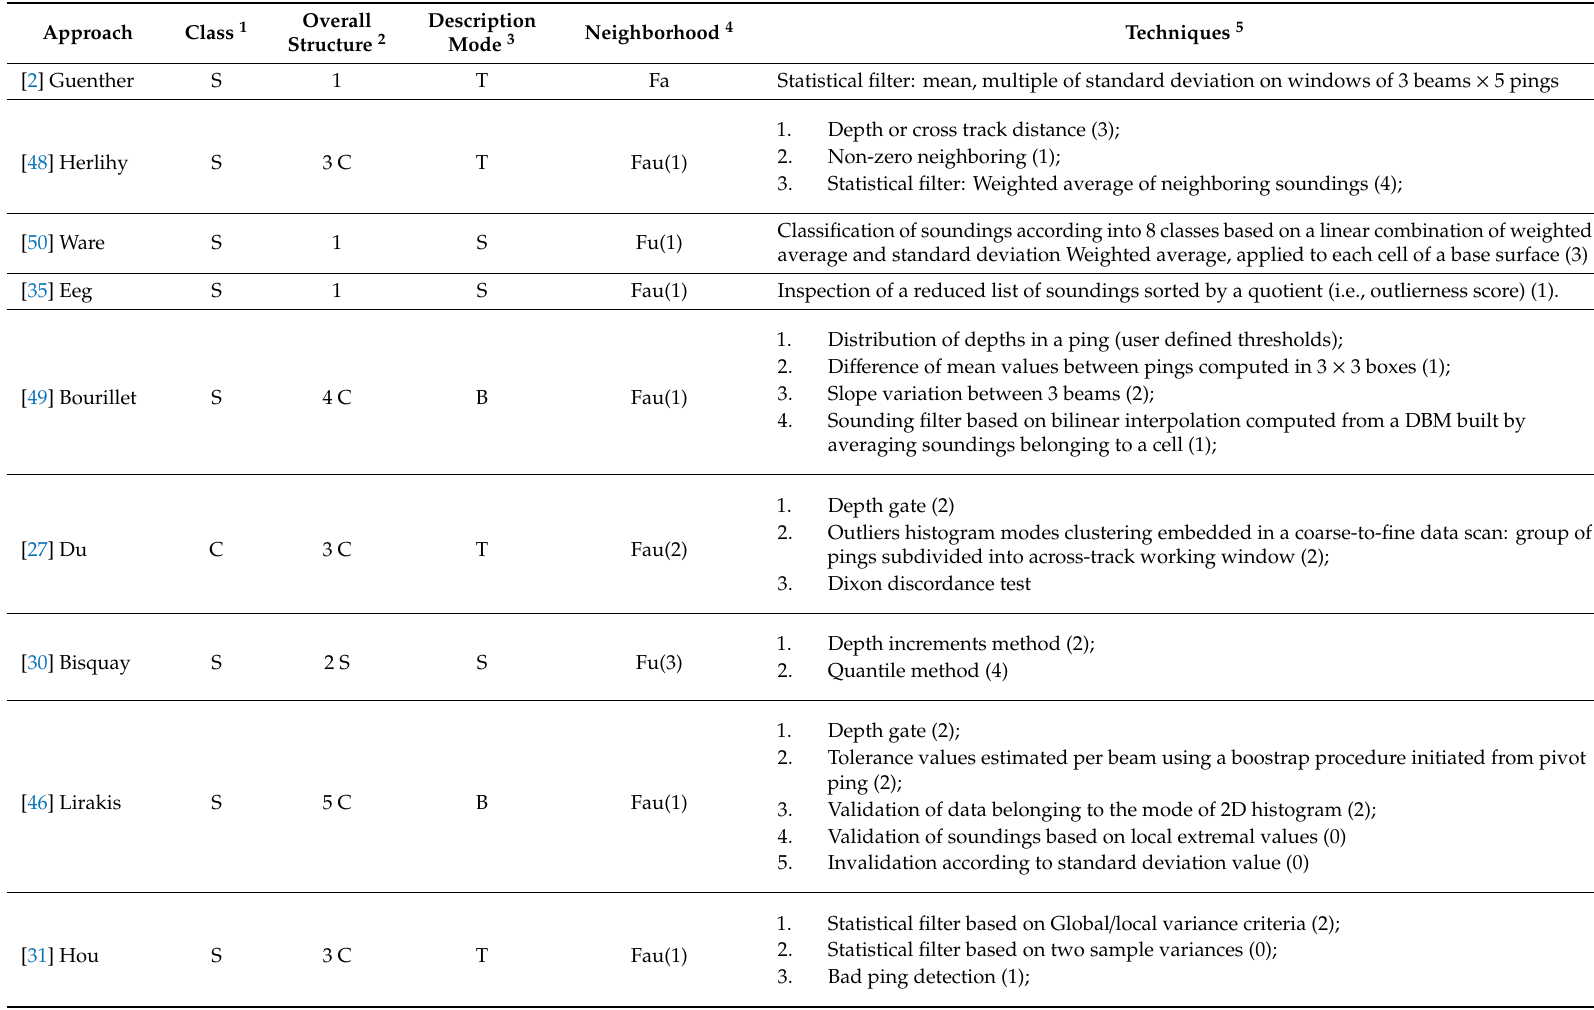
Table 2. Characteristics of